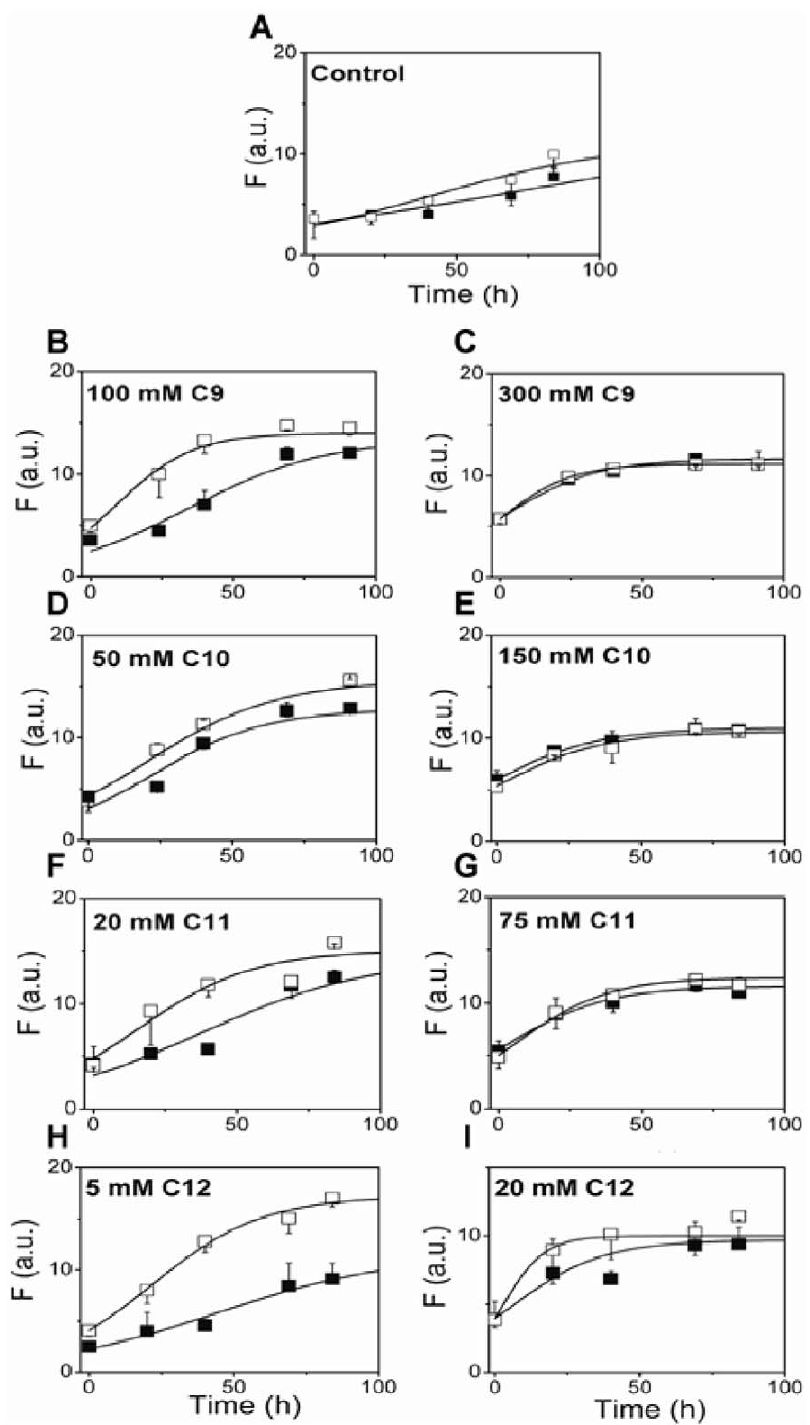
Figure 6. Seeding experiments with oligomers. (A–I) A b monomer (25 m M) was incubated alone or with 10% (m/v) seed of 48 h incubated samples of Figure 5 at 37 u C and monitored by ThT fluorescence. The figures on the left and right panel represent concentration near and above the CMCs respectively. The unseeded control ( & ) is same reaction as the seeded ( % ) one, but lacks seed.